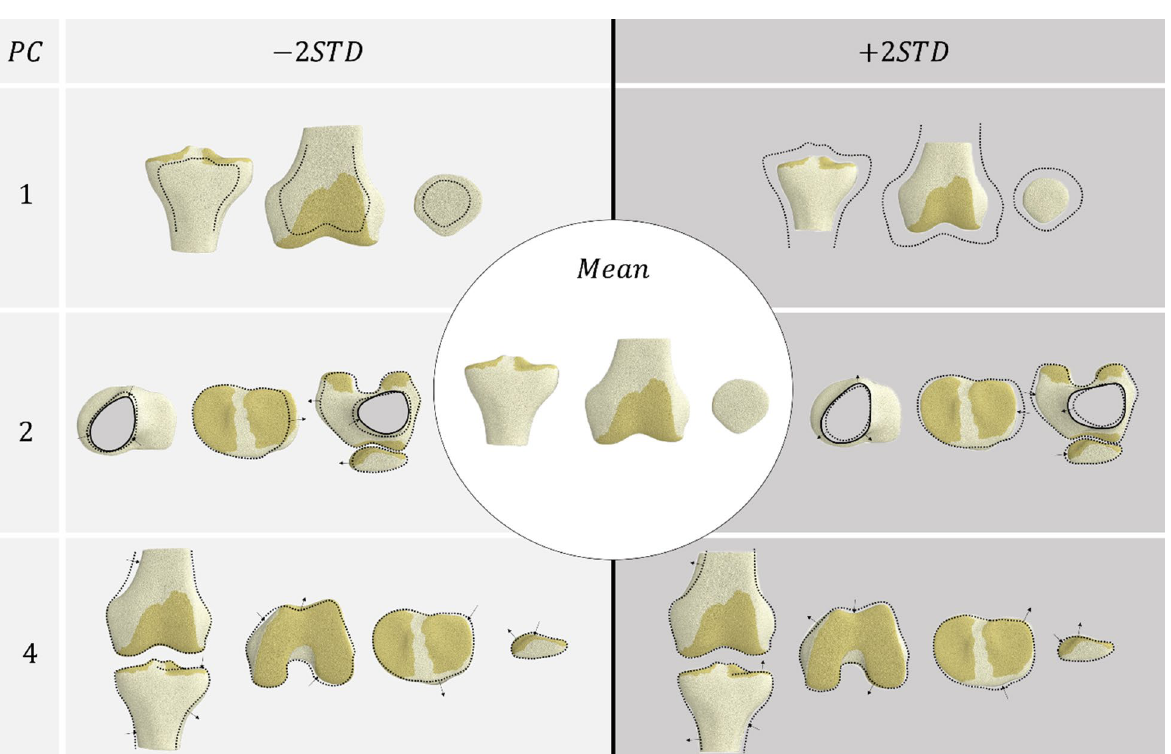
Figure 4. Coupled variations in bone shape of the SSFM showing principal components that were influenced by sex and height (PC1 and PC2) or sex